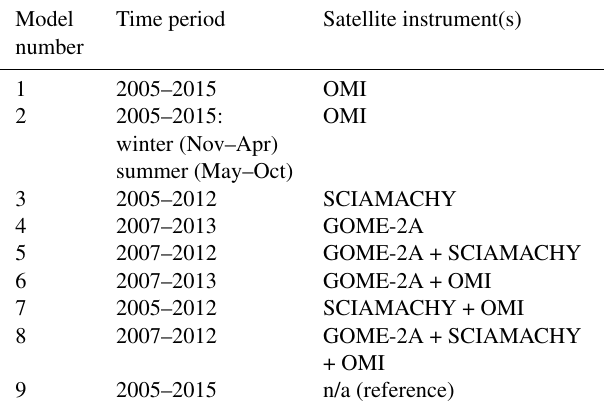
Table 2. The LUR models considered in this work, showing the time period and satellite instruments used. Note that model 9 is a multiple linear regression model which does not include satellite data or random